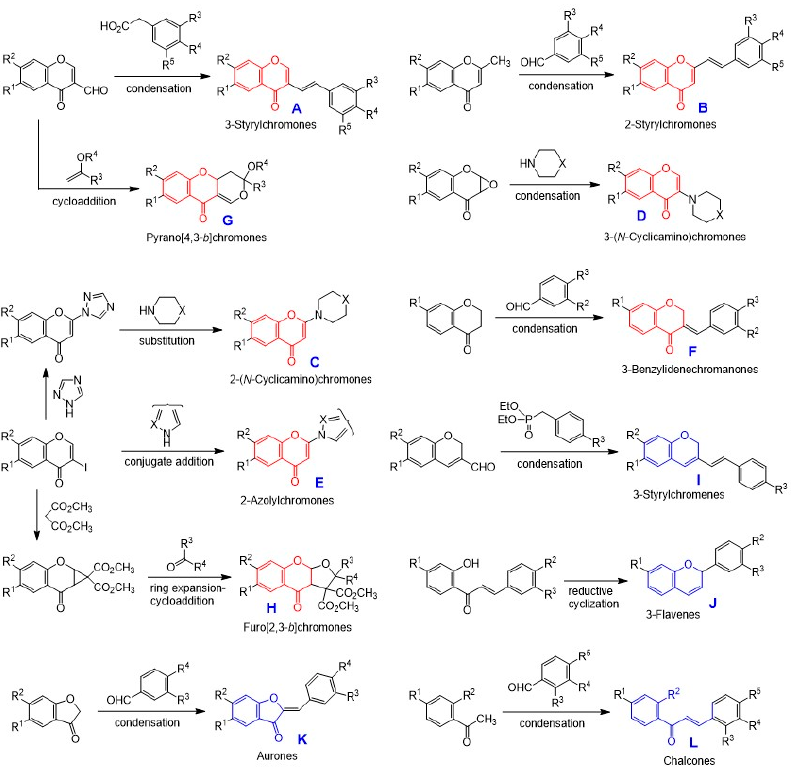
Figure 5. Synthesis of chromone derivatives.